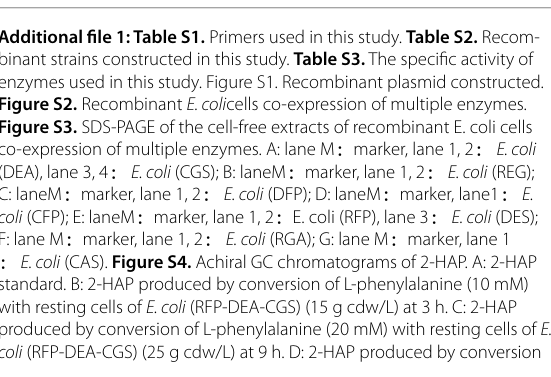
： E. coli (CAS). Figure S4. Achiral GC chromatograms of 2-HAP. A: 2-HAP standard. B: 2-HAP produced by conversion of L-phenylalanine (10 mM)